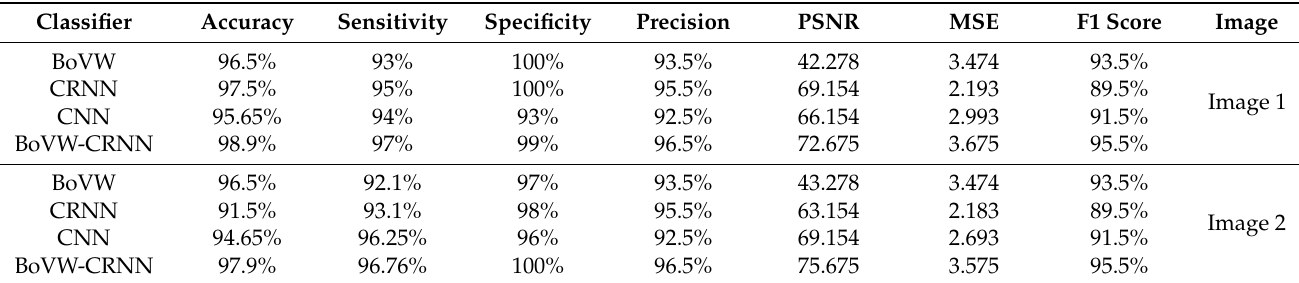
Table 6. Analysis of performance